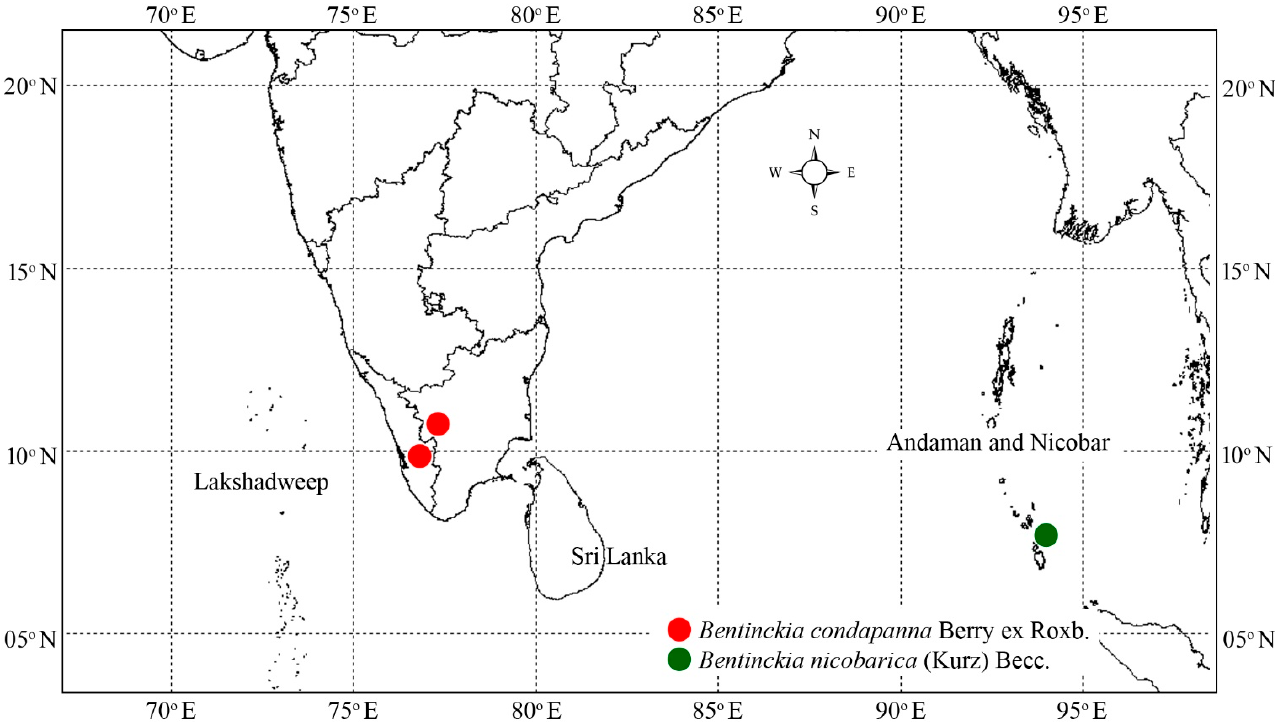
Figure 3. Distribution map of Bentinckia condapanna and B. nicobarica.